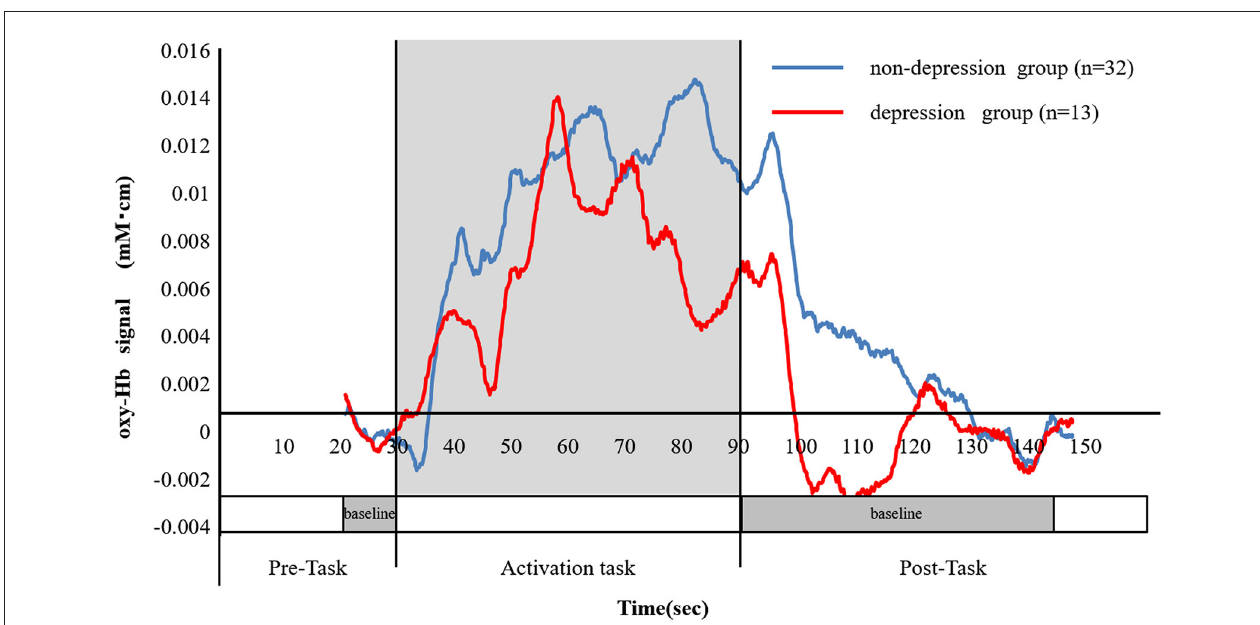
FIGURE 5 | The change in the ratio of the oxy-Hb between the depressed and non-depressed groups. The blue line shows the mean oxy-Hb values in the non-depressed group ( n = 32), while the red line shows the mean oxy-Hb values in the depressed group ( n = 13). The mean of the oxy-Hb integral values in the non-depressed group was significantly higher than those of the depressed group (3.16 ± 2.7 and 1.71 ± 2.4, respectively, P = 0.040).